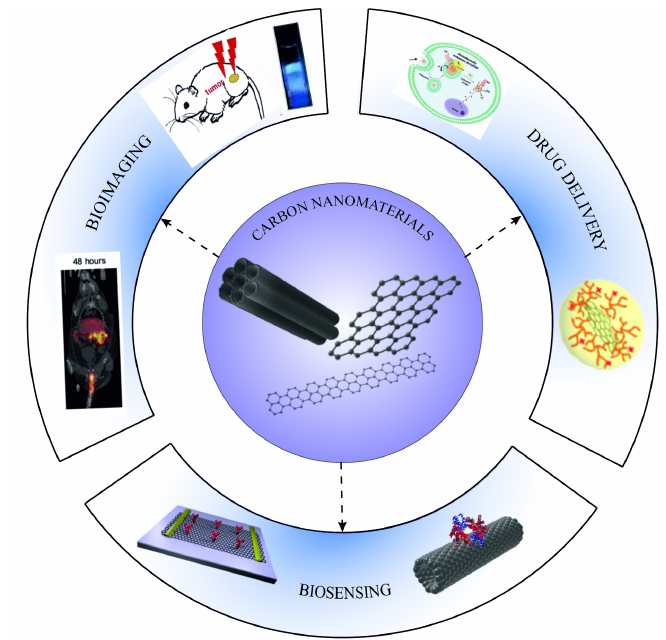
Figure 3. The primary application of graphene-based nanomaterials in biomedicine: bioimaging, drug delivery, biosensing. Some of the included images were adapted with permission from [104,105]. Copyright 2013, American Chemical Society. Copyright 2016, with permission from